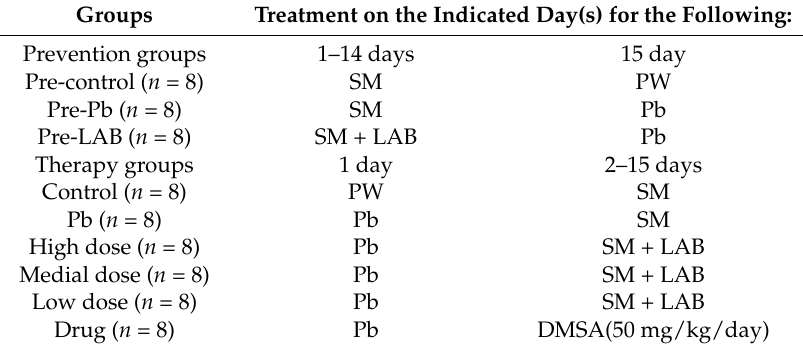
Table 1. Experimental design of the prevention and therapy groups. Groups Treatment on the Indicated Day(s) for the